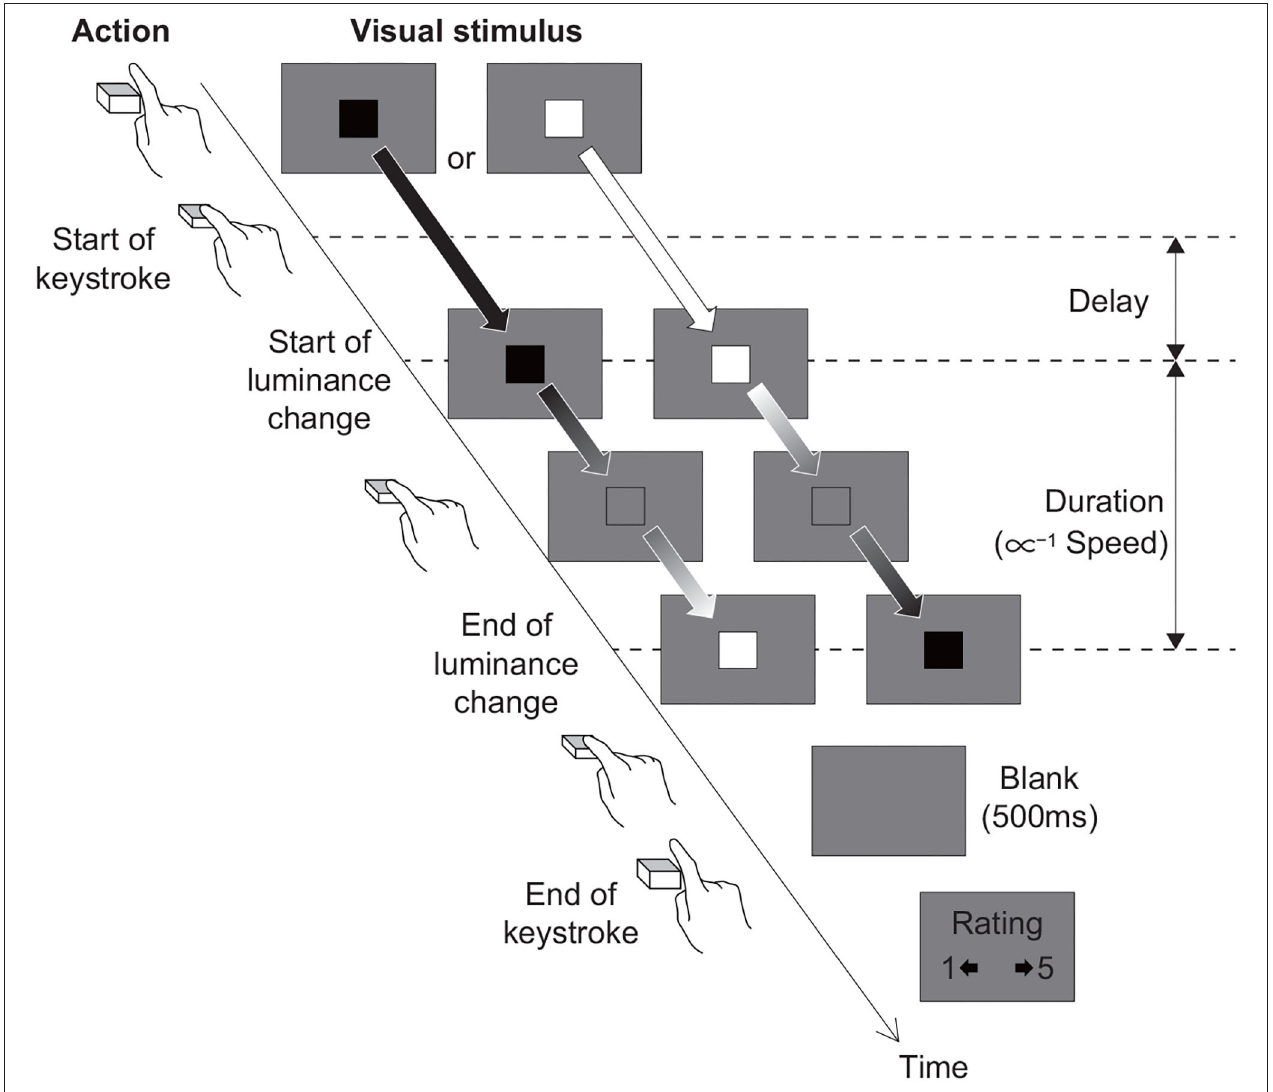
FIGURE 1 | Trial sequence of experiments.